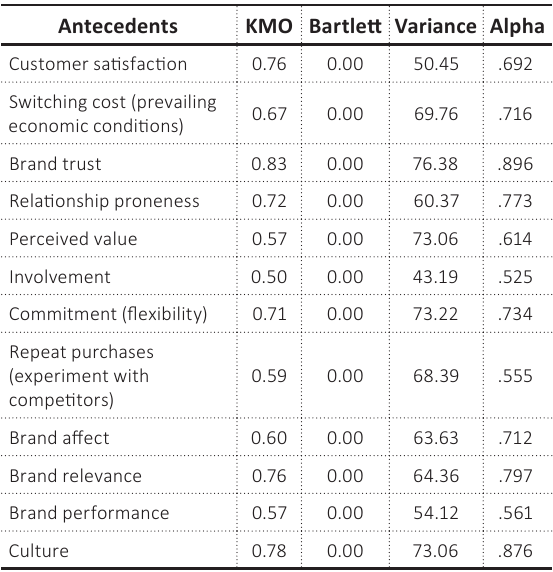
Table 4. The KMO, Bartlett’s test, variance